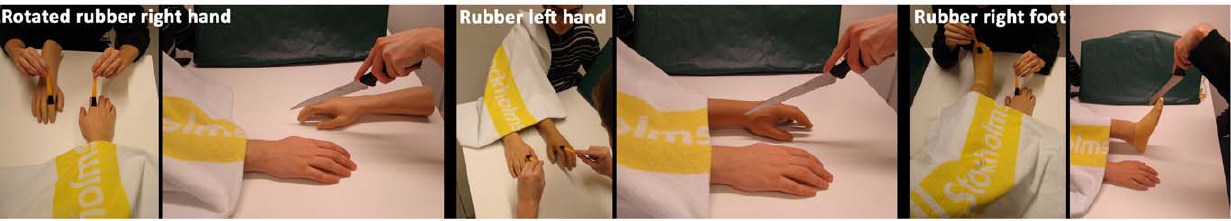
Figure 2. Control conditions. Set-ups used for the three different control conditions used in experiments 1, 3 and 4. The application of the brushstrokes on the real and artificial limbs is demonstrated in the left picture of each picture pair; to the right, the procedure of threatening the rubber limb with the knife is depicted. From left to right: the rotated rubber right hand, rubber left hand and rubber right foot conditions.